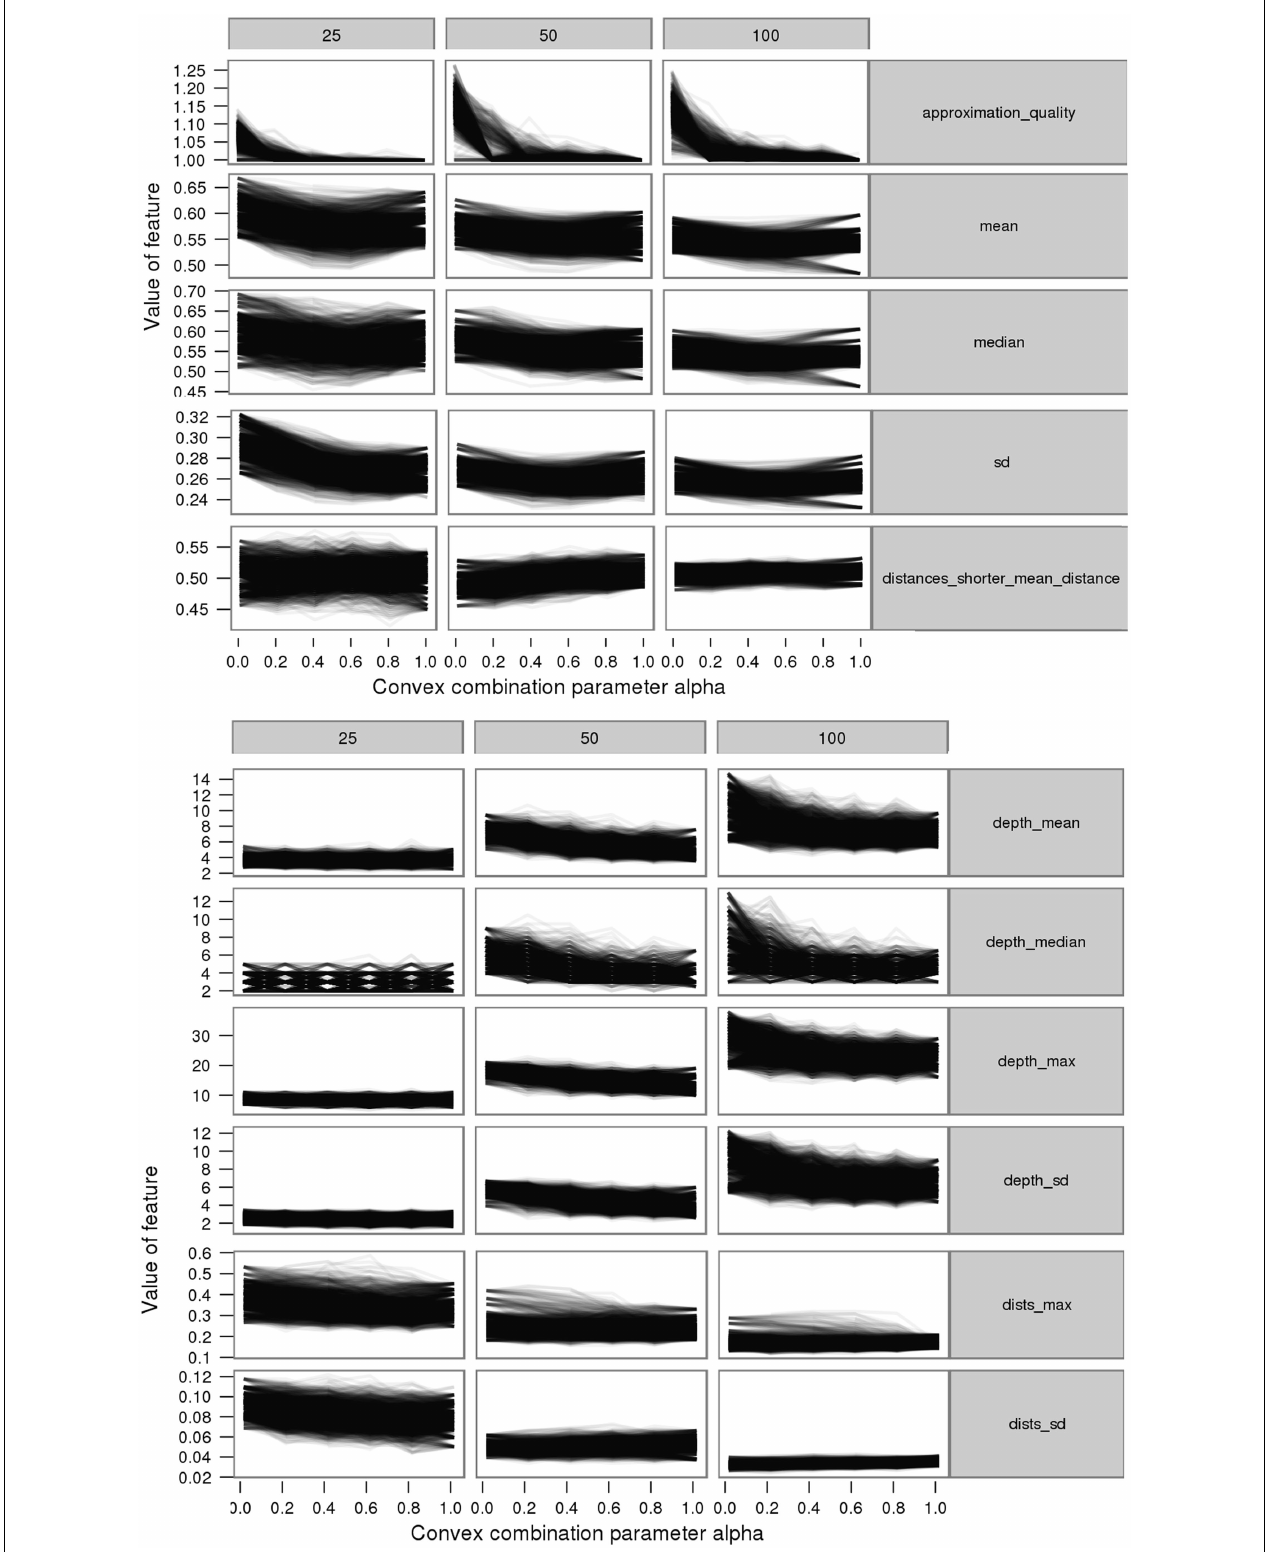
FIGURE 4 | Feature variation with instance difficulty for some exemplary features from distance (top) and minimum spanning tree (bottom) feature groups for the default parameter setting ( (cid:11) =1, (cid:12) =2) .